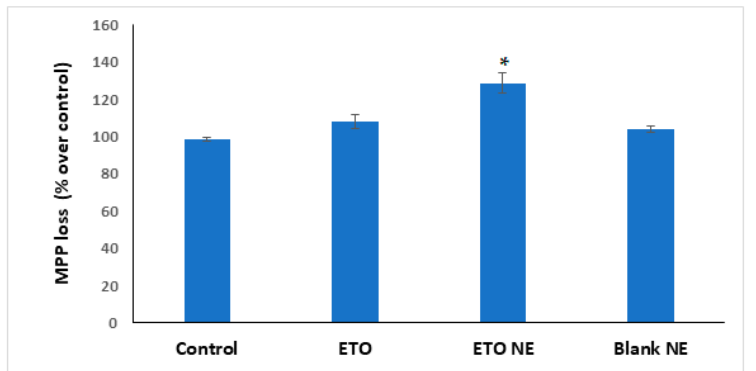
Figure 9. Effect of different formulations on mitochondrial membrane loss (MMP). Data are expressed as (mean ± SD, n = 3), where * denotes significant difference between ETO NE ( p < 0.05) vs. free ETO, blank NE and control group.